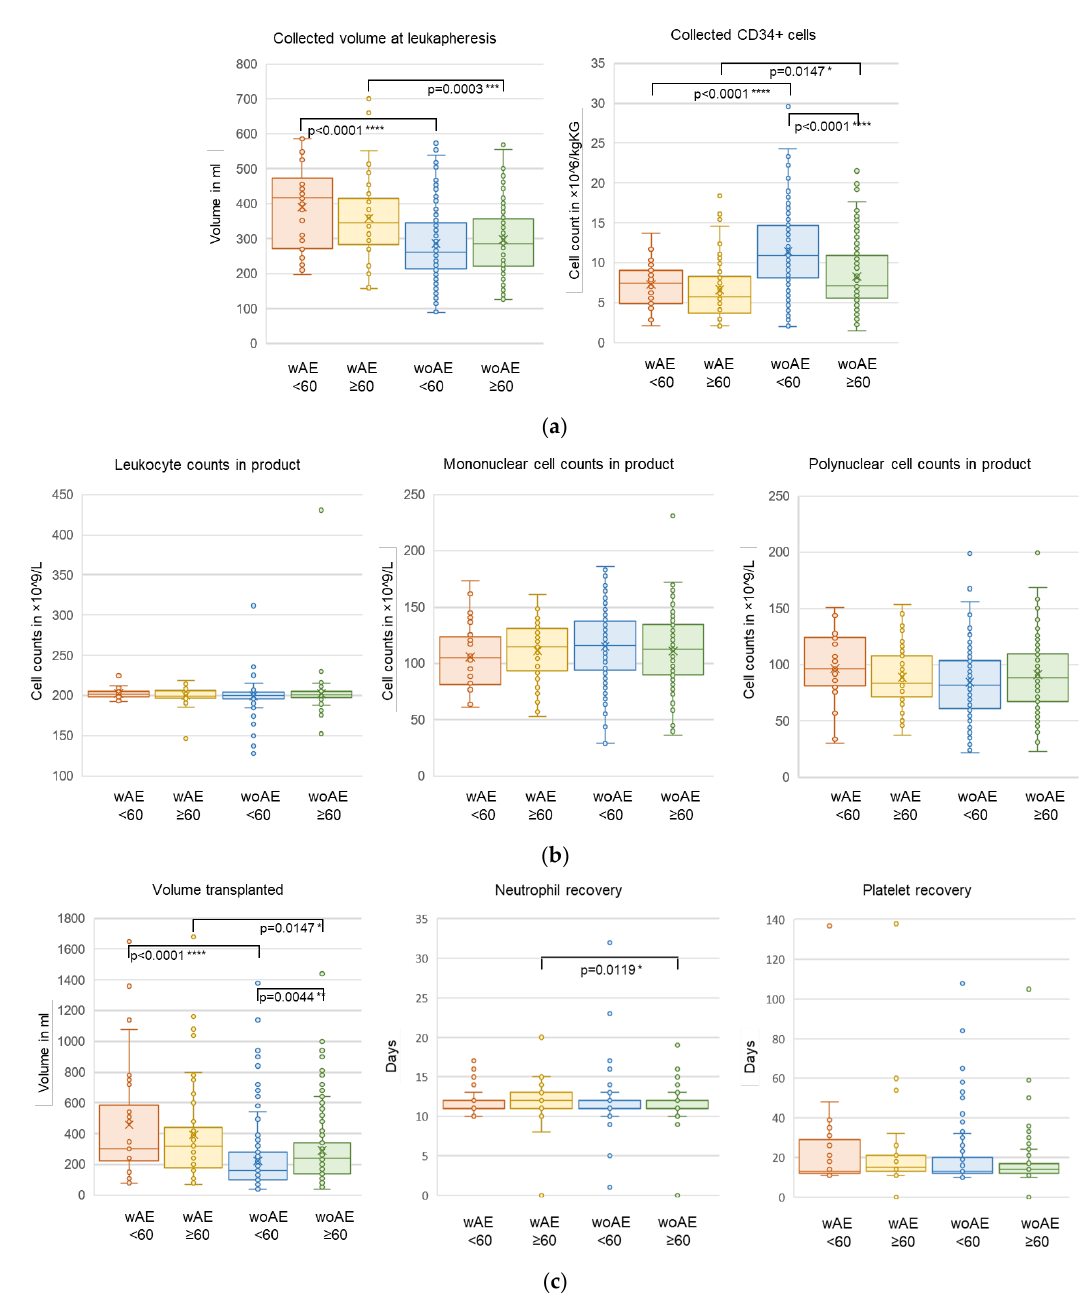
Figure 3. Parameters according to AEs and age. ( a ) Collected volumes and CD34+ cells during leukapheresis, ( b ) numbers of Lc, MNC, and PNC in the transplant product, ( c ) total transplanted volumes and times to reach an absolute neutrophil count of >0.5 × 10 9 /L and a platelet count of >20 × 10 9 /L. Data without the CD34+-selected transplants; significance: * p ≤ 0.05, ** p ≤ 0.01, *** p ≤ 0.001, **** p ≤ 0.0001 .